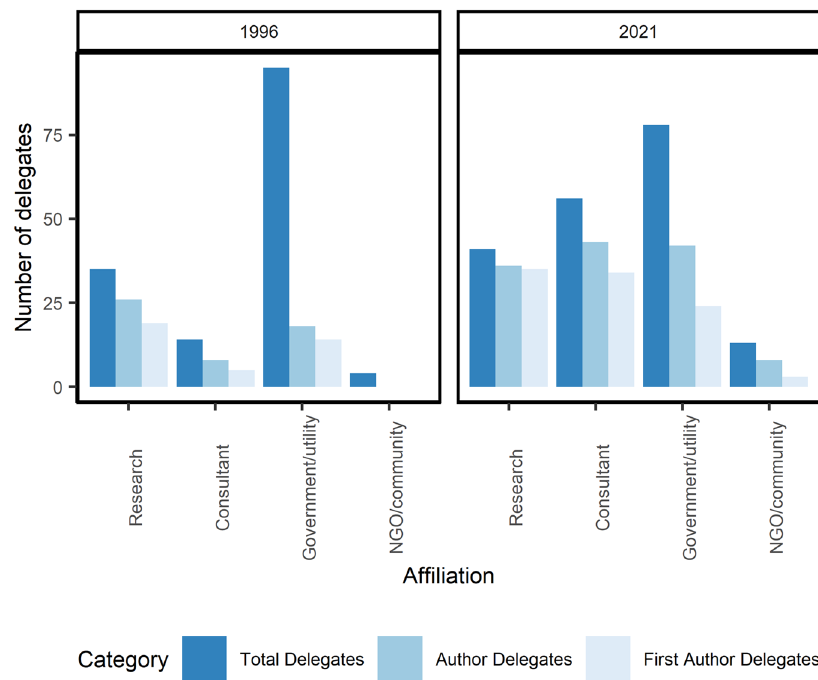
Fig. 2 Delegate af fi liation categories and representation as authors in 1996 and 2021. Total delegates are shown in darkest blue, delegates who were also authors in mid blue, and delegates who were also fi rst authors in lightest blue. Researcher delegates remained strongly represented as authors over time, while consultant and government representation as authors increased. Note that for the 2021 conference (which was held online), delegate representation was similar to the 2018 conference which was held in person (see Supplementary Table 2).